Question: Write a single sentence explaining what this figure depicts.
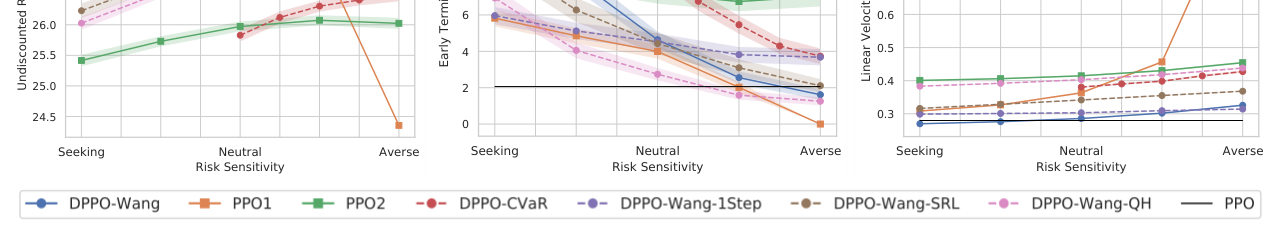
Answer: Average undiscounted return, fraction of episodes in which the robot terminates before episode end, and L2 distance between commanded and actual linear velocity. PPO baseline is included for reference and does not change with risk sensitivity. Shaded regions show 95% confidence intervals across evaluation spawns. Only a single seed was trained for each method due to computation constraints. Methods are listed in table I.